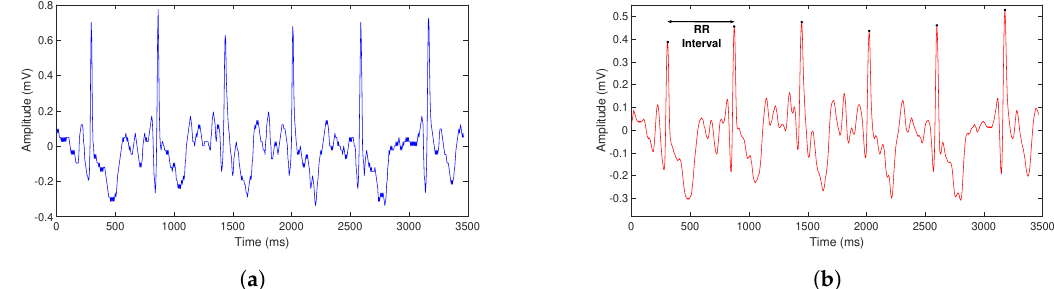
Figure 6. Transformation of the signal before ( a ) and after ( b ) applying the filter function